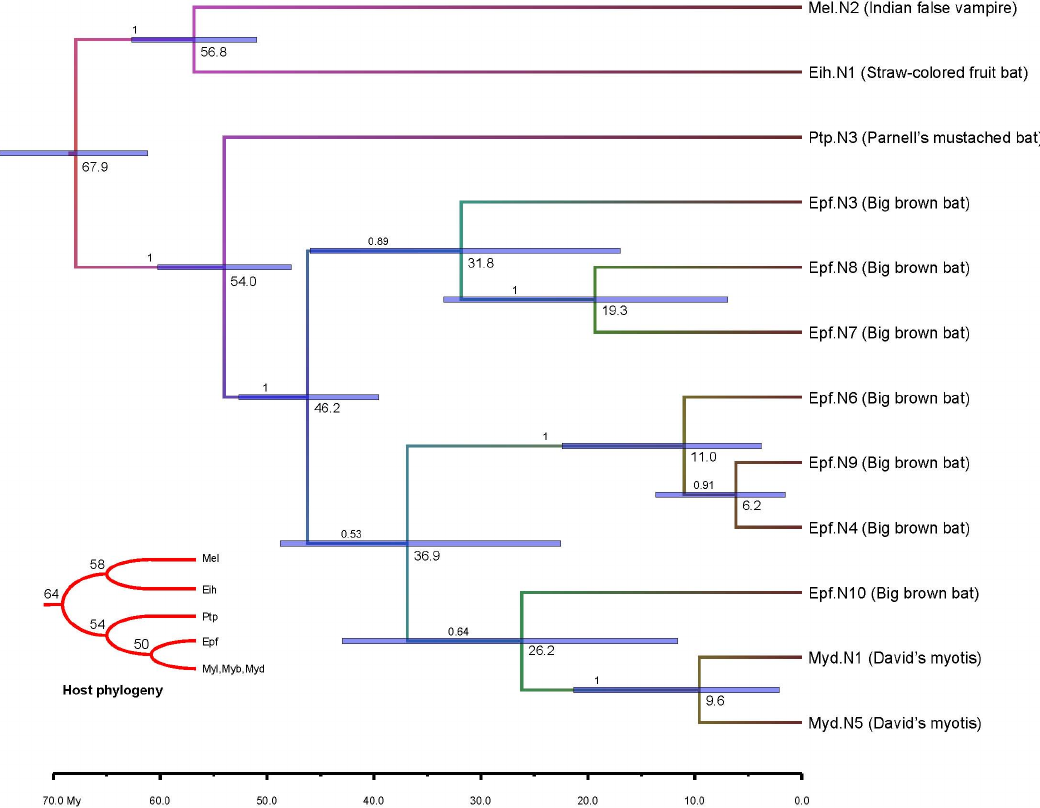
Figure 3. Time-scaled bat bornavirus evolution. The abbreviations of bat hosts represent bat EBLNs. A host species tree, with divergence time (My) marked, is embedded to highlight the virus-host co-divergence. Key nodes represent ages (My) of root-to-tip and 95% credible intervals are shown by horizontal bar. Bayesian posterior probabilities are given on the branches.